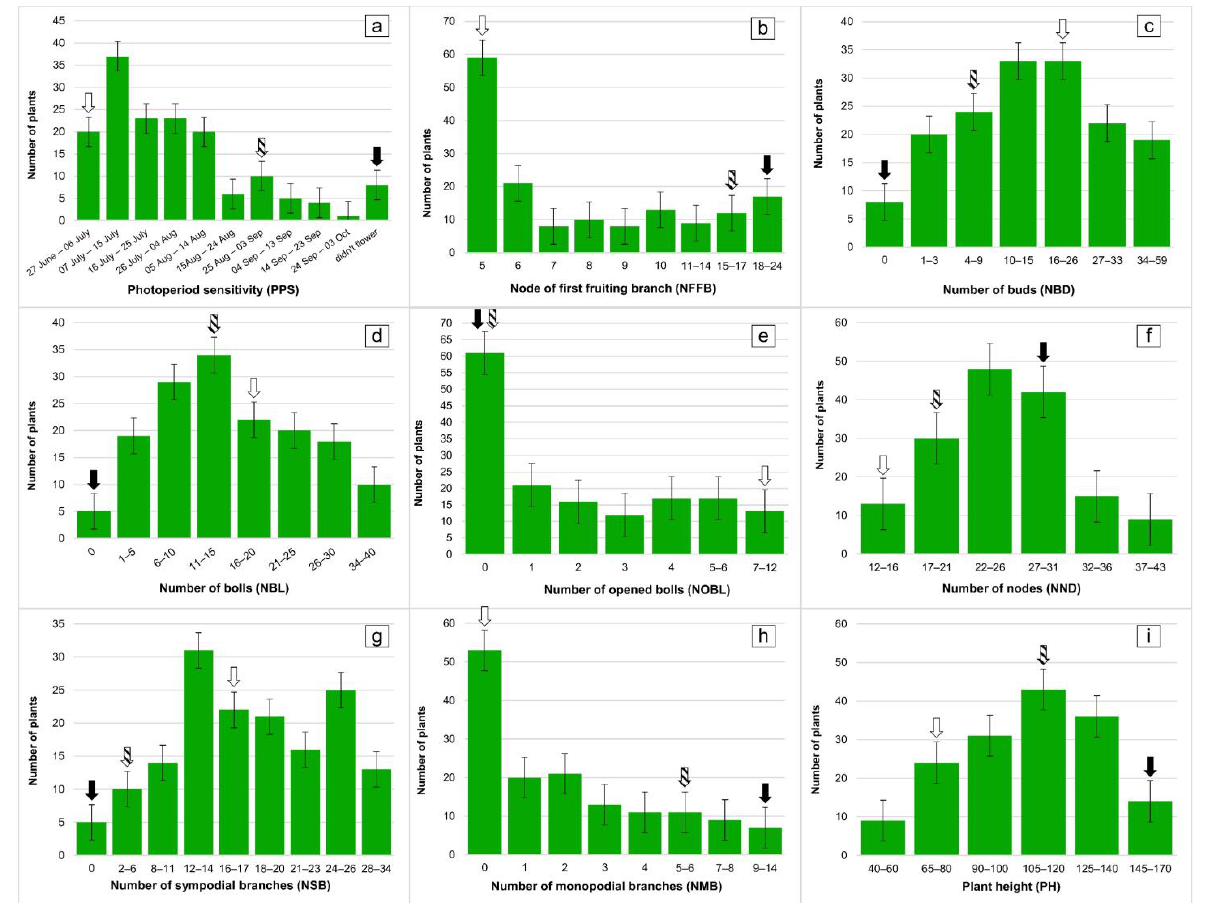
Figure 2. Histograms of the cotton traits related to flowering time and photoperiod sensitivity in the F 2 progeny. ( a ) Photoperiod sensitivity (PPS); ( b ) node of first fruiting branch (NFFB); ( c ) number of buds (NBD); ( d ) number of bolls (NBL); ( e ) number of opened bolls (NOBL); ( f ) number of nodes (NND); ( g ) number of sympodial branches (NSB); ( h ) number of monopodial branches (NMB); ( i ) plant height (PH). The arrows show means for parental genotypes and F 1 hybrid; white arrow — mutant line (Kupaysin); black arrow — wild type; arrow with patterned fill — F 1 plant. In the F 2 progeny, the following parameters were obtained: the plant height is 110 cm;